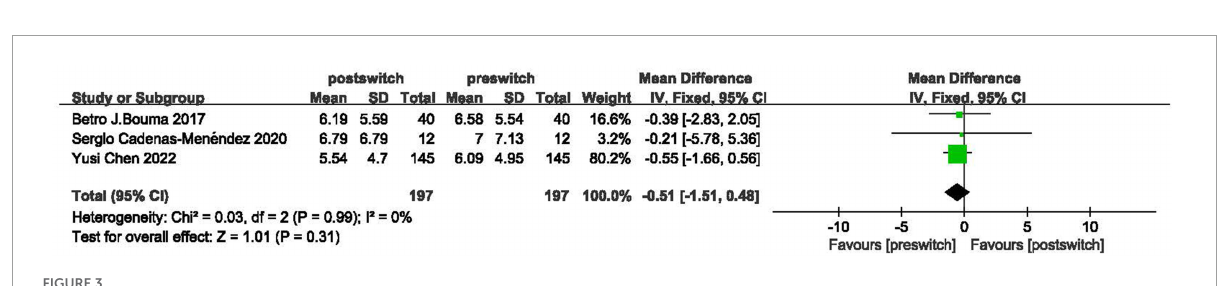
(bosentan or ambrisentan) to macitentan can improve the 6MWD and WHO-FC and have safety